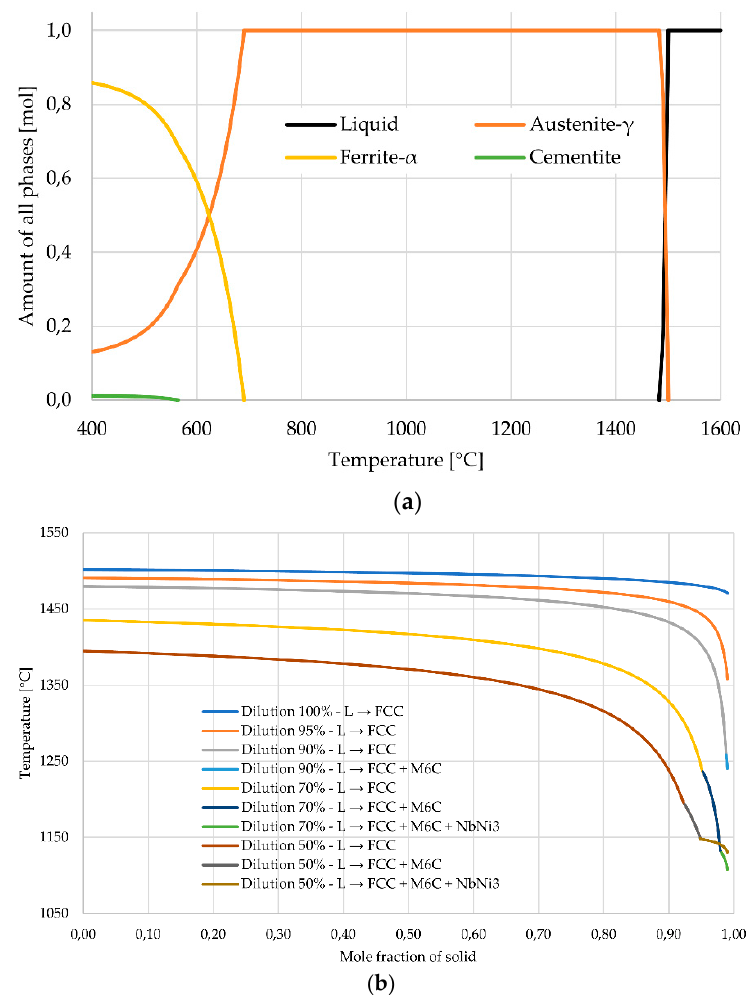
Figure 13. Thermodynamic simulation of phase fractions present in 9%Ni steel as a function of the temperature ( a ) and thermodynamic simulation of the solidification, based on the Scheil-Gulliver model, as functions of the dilution levels in the transition zone of substrate/clad (TZ-S/C) ( b ). The caption of ( b) (color fields) indicates the phases present during the solidification of 9%Ni steel and clad for different dilution levels of the partially mixed zone.